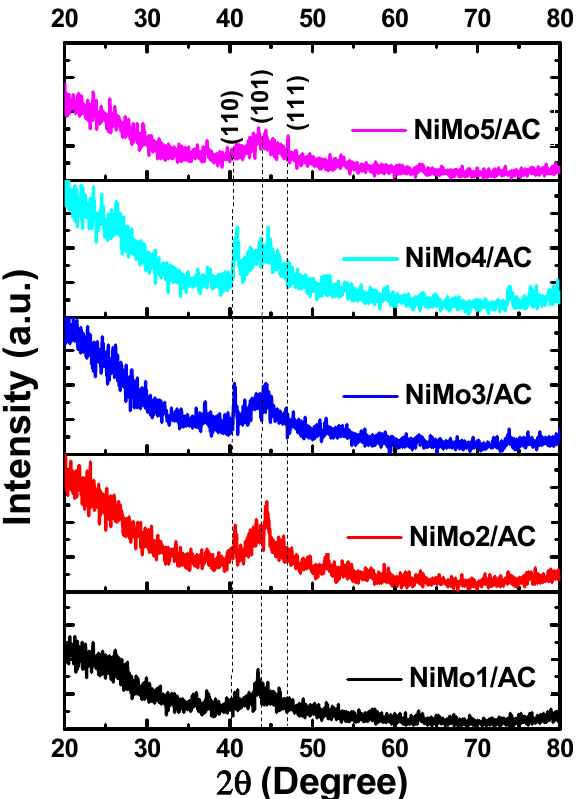
Figure 1. XRD patterns for the prepared composites.